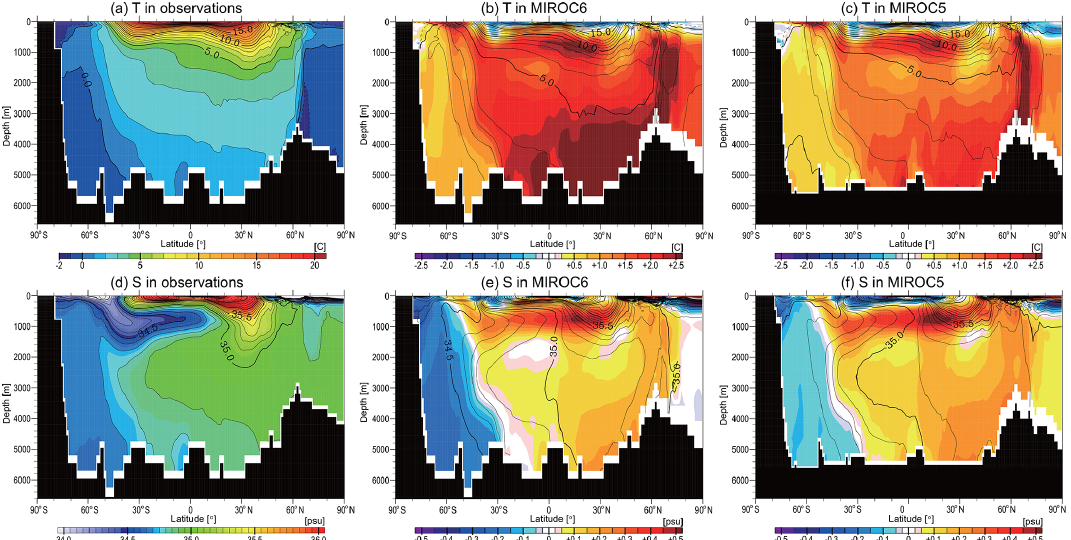
Figure 13. Annual mean potential temperature ( a, b, c ; unit is ◦ C) and salinity ( d, e, f ; psu) in the Atlantic sector for observations (a, d) , MIROC6 (b, e) , and MIROC5 (c, f) . Colors indicate errors with respect to observations (ProjD) and contours denote model values in (b, e) and (c, f)